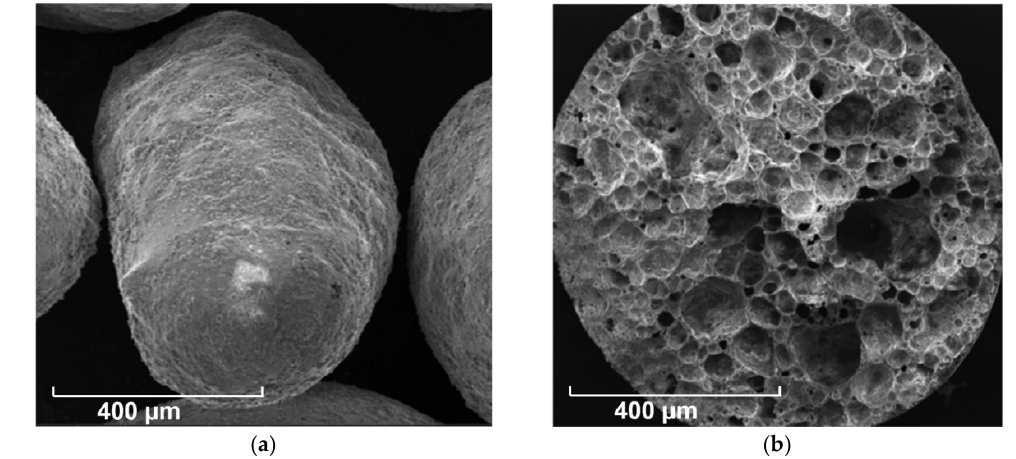
Figure 3. SEM pictures of outer surface and inner porous structure of LWAs: ( a ) LWA-3, ( b ) 0.5–1.0 mm.